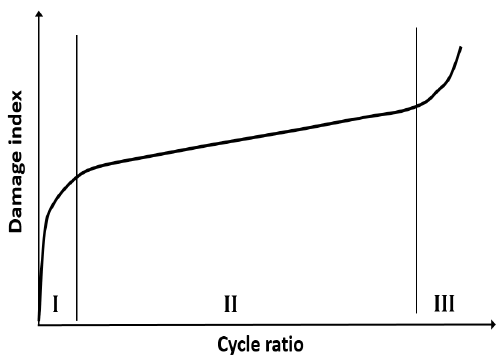
Figure 9. Schematic of the fatigue damage evolution in composites